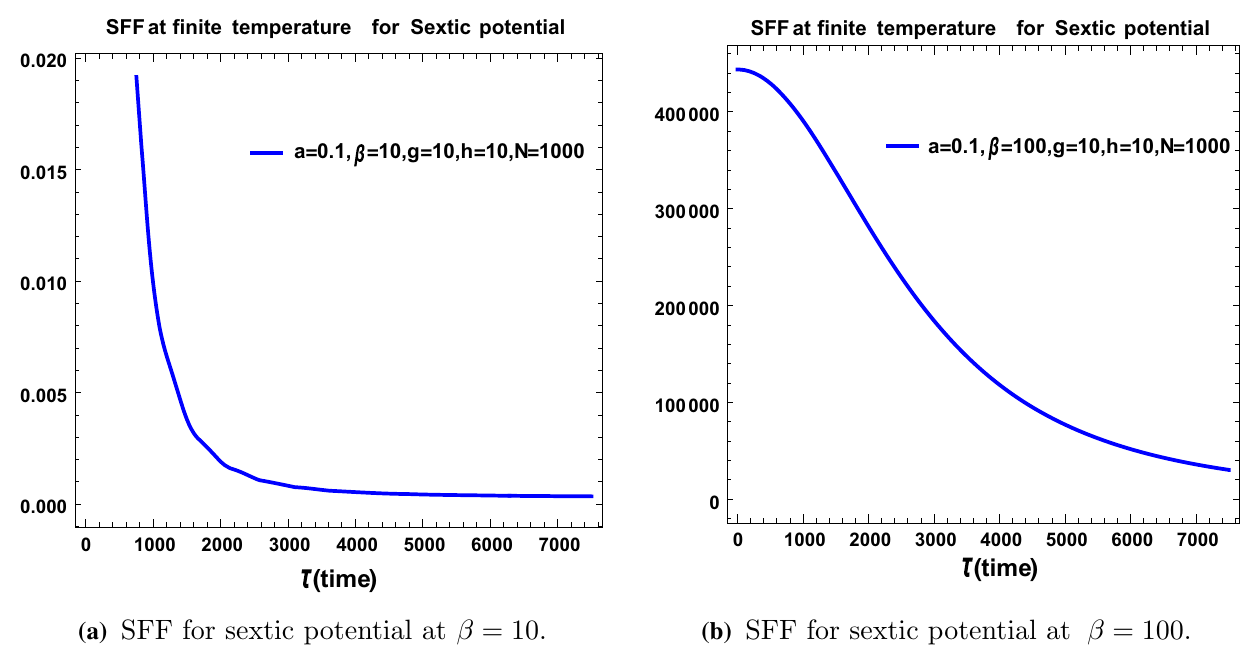
Fig. 29 Spectral Form Factor for sextic potential at different finite temperature[ β ] with N = 1000 and a = 0 . 1